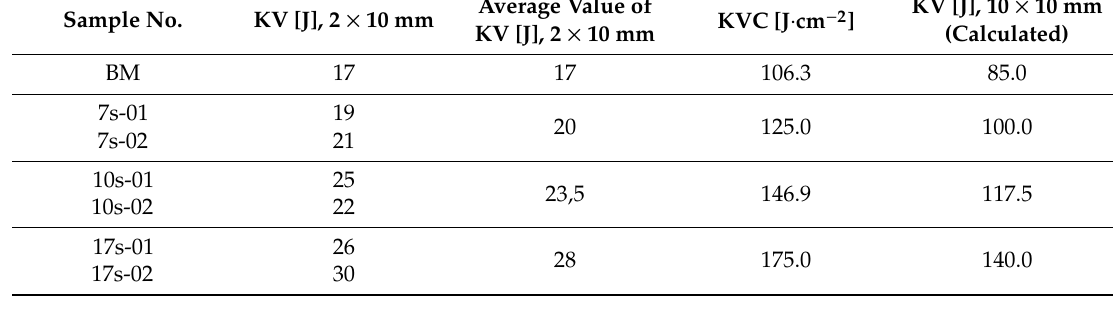
Table 4. Results of the Charpy pendulum impact test (at the temperature of − 40 ◦ C) for the base material and samples a ff ected by the thermal cycle under di ff erent cooling times t 8 / 5 . Sample No.